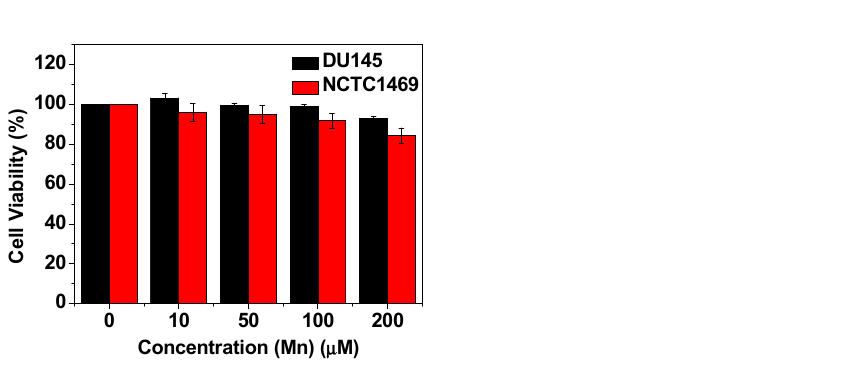
Figure 7. Cell viabilities of NCTC1469 and DU145 cells for the FA-PAA-coated MnO nanoparticles, exhibiting very low toxicities of up to 200 μ M Mn.